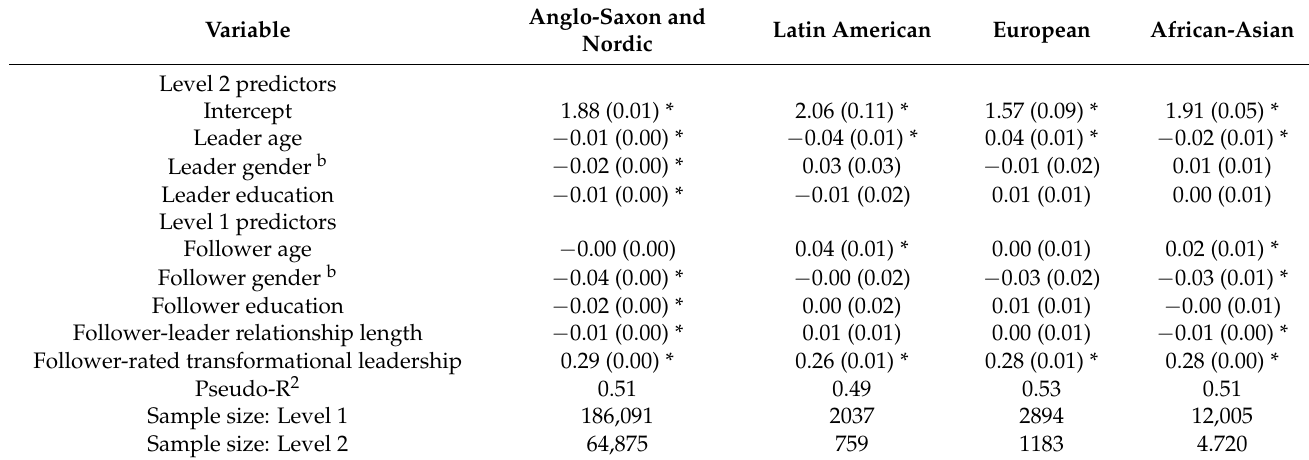
Table 3. Multilevel models of cultural-comparative satisfaction with leader a . Anglo-Saxon and Latin American European Nordic